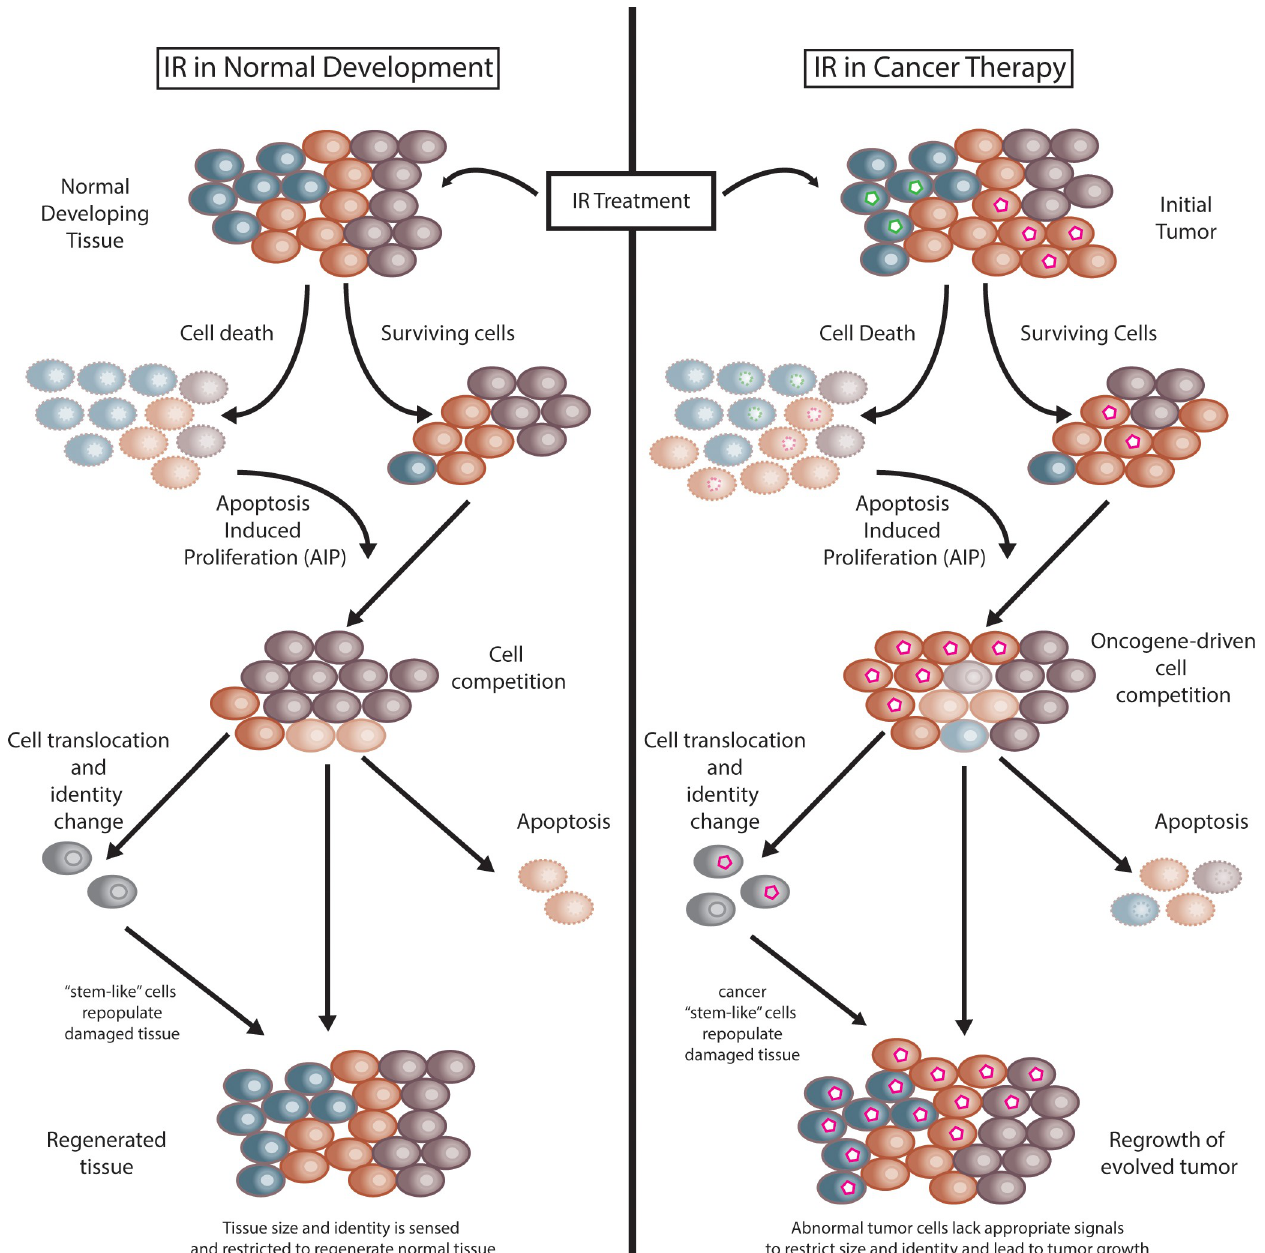
Fig 1. The effects of IR in normal tissue regeneration and in cancer therapy. IR is used to treat tumors in human cancers but can also be utilized to model tissue damage and regeneration after injury. (Left) In normal tissues consisting of diverse cell types (depicted as differently colored cells), IR induces cell death, and AIP can stimulate surviving cells to repopulate the damaged tissues. As cells proliferate, cell competition between pools with different proliferative capacities may occur. As a consequence, cells may contribute via different mechanisms to regenerate tissues, including proliferating to replace dead cells, undergoing apoptosis, and translocating and changing identity (gray cells) to fully regenerate all cell types in the tissue. (Right) Similar pathways may be activated after IR treatment of tumors. However, genetic changes (green or pink hexagonal nuclei) in cancer cells abnormally increase proliferative capacity and suppress apoptosis. These properties can lead to oncogene-driven cell competition within the tumor mass after irradiation, leading to expansion of cancer cell pools. Attempts to regenerate the tissue, however, are deregulated as oncogenes can drive overproliferation of tumor cells, evade apoptotic signals, and generate cancer stem-like populations of cells (gray cells with pink hexagons) that can regain proliferative capacity. Ultimately, the newly evolved tumor lacks signals that would restrict growth and normal development and will be genetically and biochemically distinct from the initial IR-treated tumor. AIP, apoptosis-induced proliferation; IR, ionizing